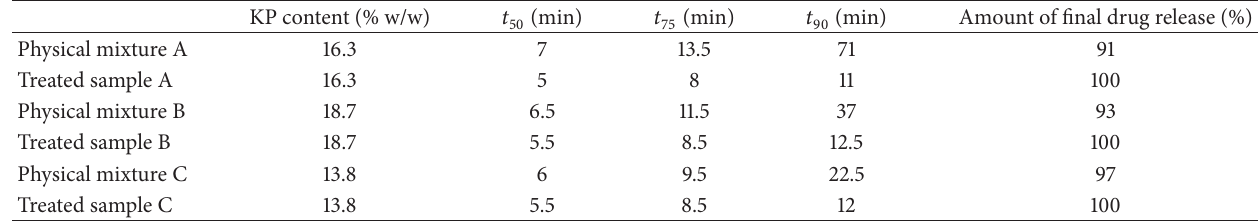
Table 2: Indices to compare the release performance of tablets obtained from the physical mixtures and treated samples (pH = 2).